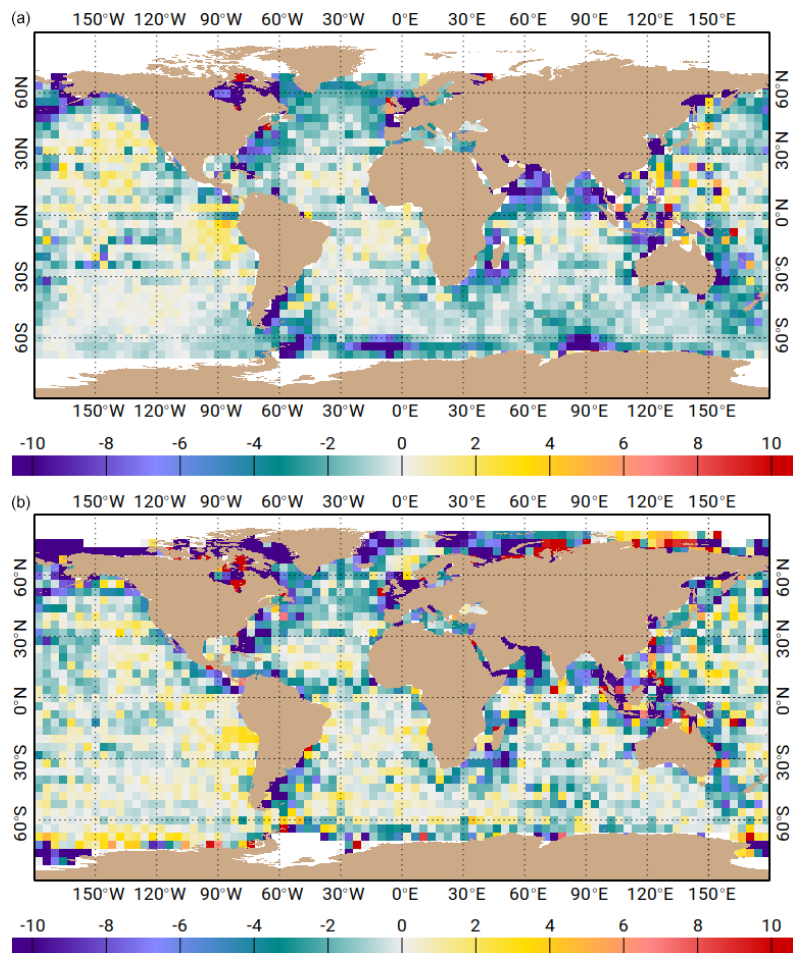
Figure 16. Maps of SSH variance differences at crossovers using either the FES2014a tidal atlas and the FES2012 atlas in the SSH calculation for the Jason-1 mission ( a , J1 cycles 1–248) and for AltiKa ( b , AL cycles 1–14, in cm 2 ). The accuracy improvement between the FES2012 and FES2014 prior solutions is a key ingredient in the accuracy improvement between the FES2012 and FES2014a assimilated solutions. Blue colours indicate a higher variance reduction when using FES2014a tidal